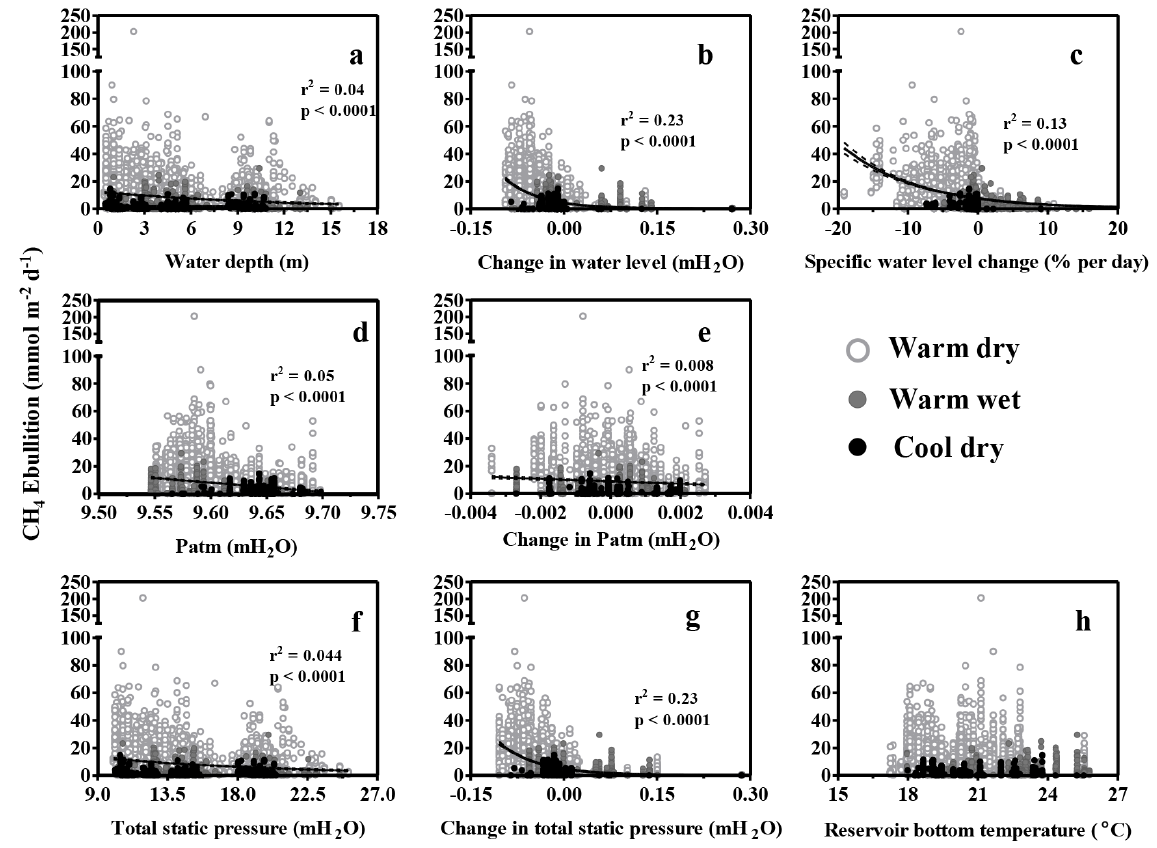
Figure 8. Ebullition measured by funnels versus (a) water depth, (b) change in water level, (c) specific water level change, (d) atmospheric pressure, (e) change in atmospheric pressure, (f) total static pressure, (g) change in total static pressure, and (h) reservoir bottom